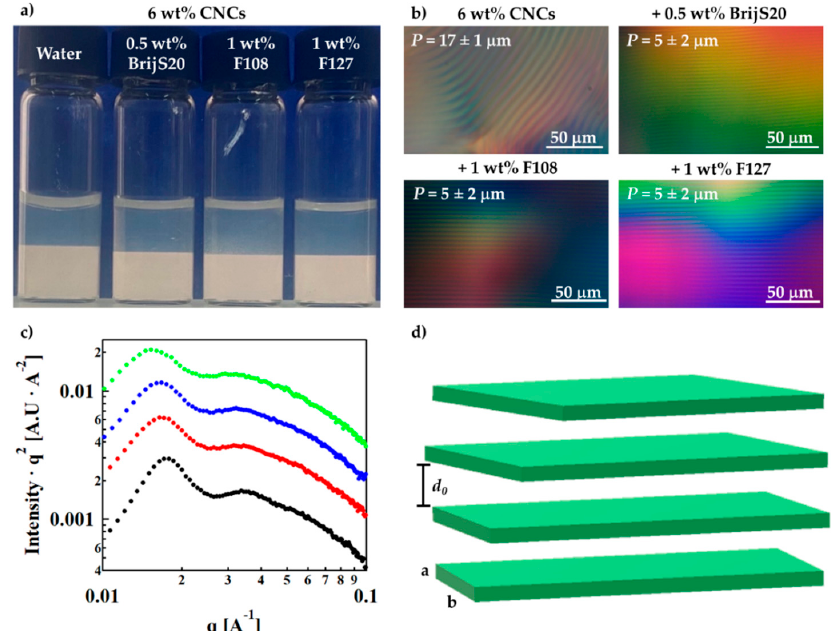
Figure 1. Suspensions of 6 wt% CNCs. ( a ) Image of vials taken between crossed polarizers, ( b ) POM images of the (lower) N* phase, ( c ) Lorentz-corrected intensity curves of 6 wt% CNCs: in water ( ), in BrijS20 solution (0.5 wt%) ( ), in F108 solution (1 wt%) ( ) and in F127 solution (1 wt%) ( ). The curves are shifted for better visualization. SAXS I vs. q curves are presented in Figure S5 of the ESI ( d ) Schematic illustration of the parallelepiped stacking model by Mao et al. [37].